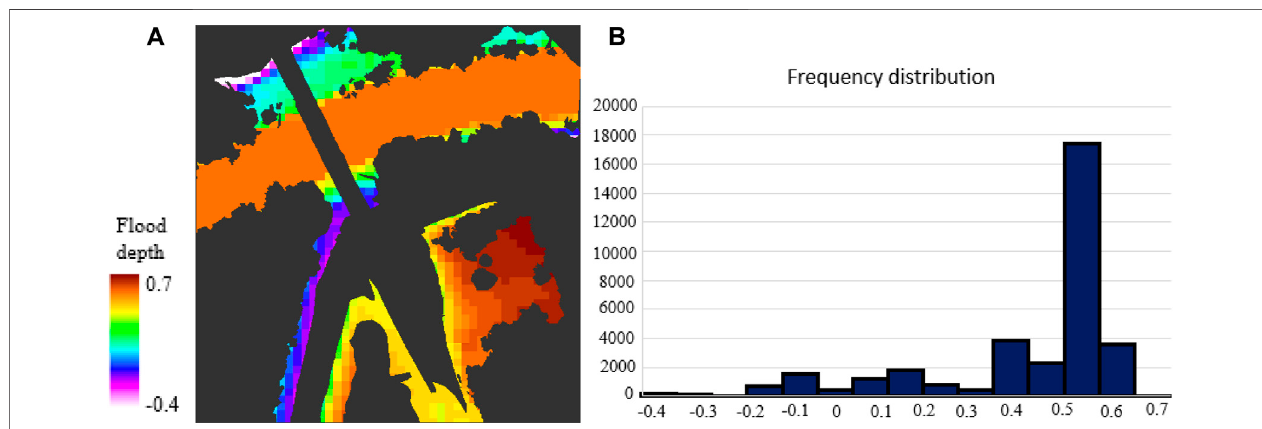
FIGURE 10 | Floodwater Depth Comparison. (A) Water depth difference map between the image classi fi cation-based method and GFI method; (B) Histograms that shows the distribution of the fl ood depth difference between the two methods.